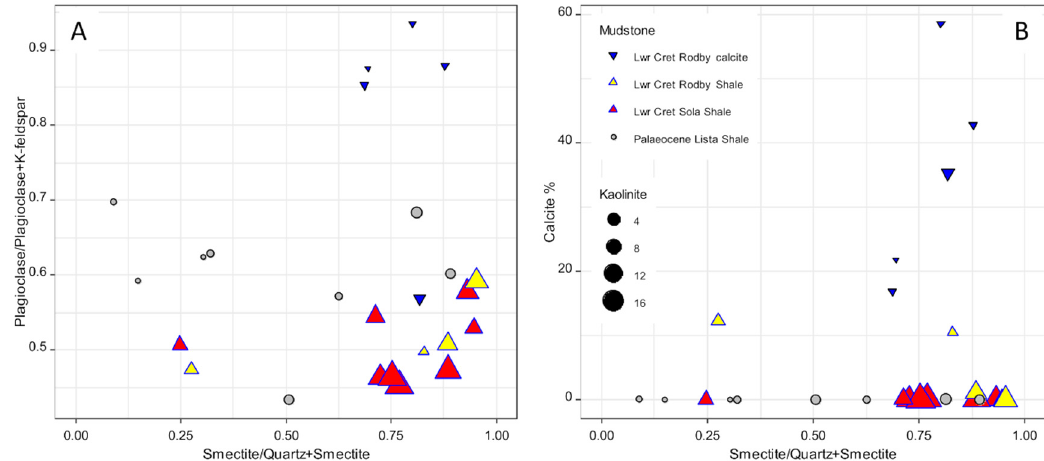
Figure 18. Comparison of SEM-EDS-derived mineralogy data for the Rodby and Lista Shales. Diagrams prepared using R-studio-ggplot2 software [15] . ( A ) smectite/(quartz + smectite) versus high plagioclase/(plagioclase + K-feldspar) ratios with data differentiated by absolute kaolinite quantities, represented by the sizes of the symbols, and split between various the Lower Cretaceous Rodby Shale, calcite-rich Rodby Shale, and intra-Captain Sola Shale and the Palaeocene Lista Shale. The highest kaolinite concentrations are associated with relatively low plagioclase/(plagioclase + K-feldspar) values and high smectite/(quartz + smectite) values. The Lista Shales tend to have relatively high plagioclase/(plagioclase + K-feldspar) values compared to the Rodby Shale, possibly rendering them more reactive to acidic fluids as might result from CO 2 injection. ( B ) smectite/(quartz + smectite) versus total calcite with data differentiated by absolute kaolinite quantities, represented by the sizes of the symbols, and split between various the Lower Cretaceous Rodby Shale, calcite-rich Rodby Shale, and intra-Captain Sola Shale and the Palaeocene Lista Shale. These shales can have a wide variety of smectite/(smectite + quartz) values. As expected, the Rodby calcite-cemented samples are easily discerned from this plot but almost all Rodby samples contain calcite.